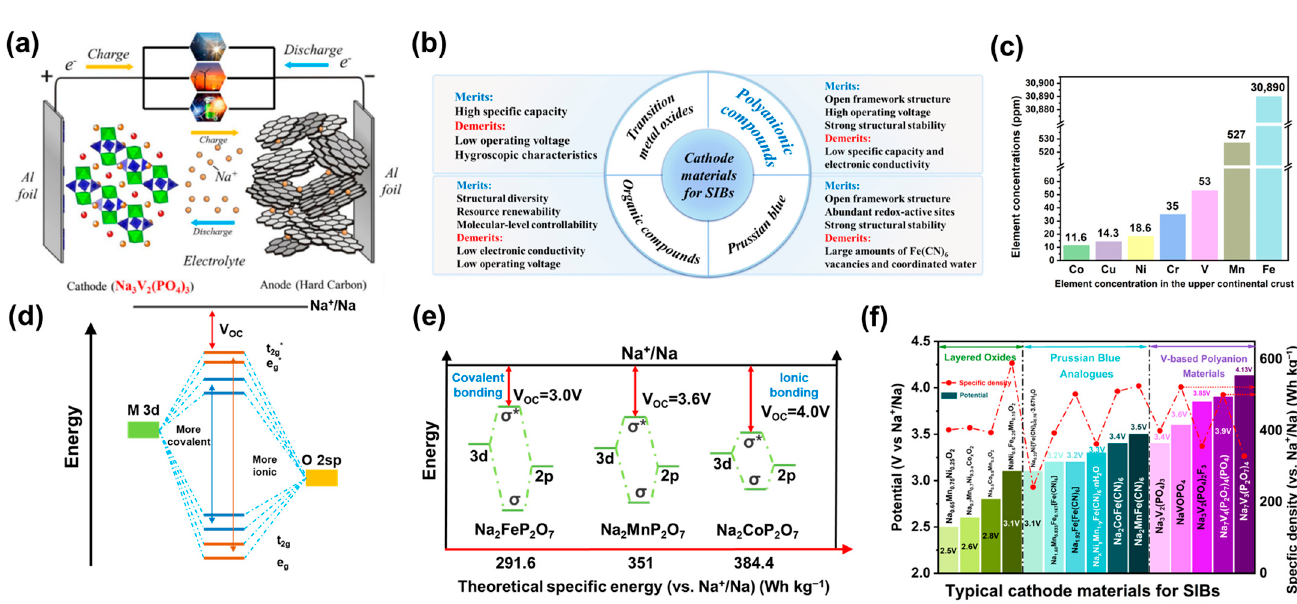
Figure 1. ( a ) Working principle of room-temperature SIBs [20]. ( b ) Comparison of various cathode materials for SIBs [20]. ( c ) Element concentrations of Co, Cu, Ni, Cr, V, Mn, and Fe (in ppm) in the upper continental crust [3]. ( d ) Schematic diagram of the influence of the M-O bond on the orbital energy level and operating potential ( Voc ). ( e ) Schematic illustration showing the relationship of Voc and theoretical specific energy (vs. Na + /Na). ( f ) Potential and specific energies (vs. Na + /Na) of typical cathode materials for SIBs. Table 1. A comparison of V-based polyanionic compounds as cathode materials for SIBs.